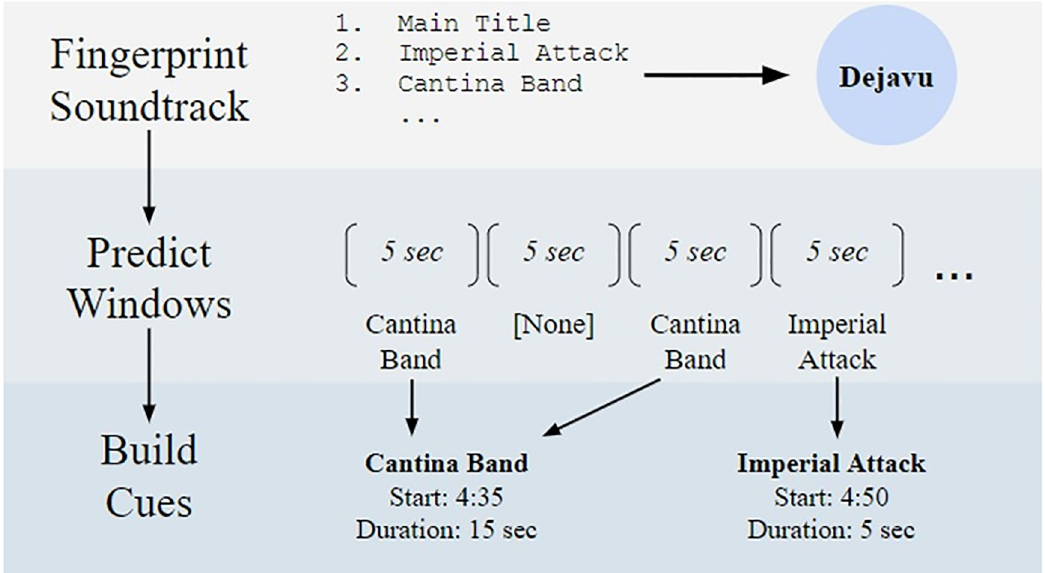
Fig 1. The Score Stamper pipeline. A film is partitioned into non-overlapping five-second segments. For every segment, Dejavu will predict if a track in the film’s soundtrack is playing. Cues, or instances of a song’s use in a film, are built by combining window predictions. In this example, the “Cantina Band” cue lasts for 15 seconds because it was predicted by Dejavu in two nearby windows.